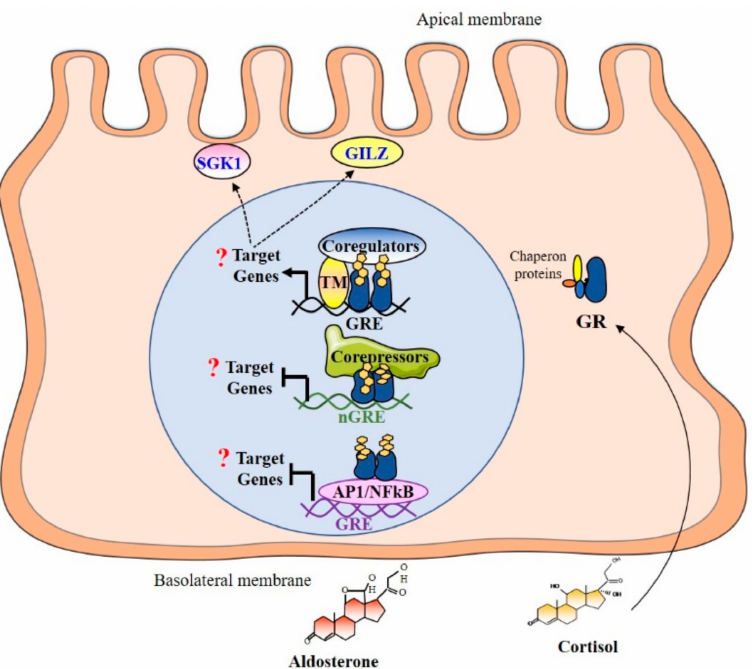
Figure 2. Mineralocorticoid and glucocorticoid signaling in renal principal cell during the perinatal period. MR signaling pathway is ineffective during renal development due to the down-regulation of MR expression. Given that renal 11 β HSD2 is not expressed during this specific perinatal period, the GR signaling pathway is therefore functional. In the nucleus, the GR can bind specific sequences called Glucocorticoid Response Elements (GREs). Binding to the GRE activates the recruitment of chromatin-remodeling complexes and coregulators. Negative GRE (nGRE) were also reported, which are responsible for trans-repression of the target genes through the binding of GR monomers. Binding to nGRE prevents the dimerization and allows for the recruitment of corepressors, thus preventing the transcription of target genes. GR can also mediate trans-repression of target genes by tethering via interactions with other transcription factors as NF κ B or AP-1 without direct binding to DNA. GR: Glucocorticoid Receptor; GRE: Glucocorticoid Response Element; GILZ: Glucocorticoid-induced leucine zipper; SGK1: Serum and Glucocorticoid-Regulated kinase 1; PER 1: clock gene period 1; TM: Transcriptional